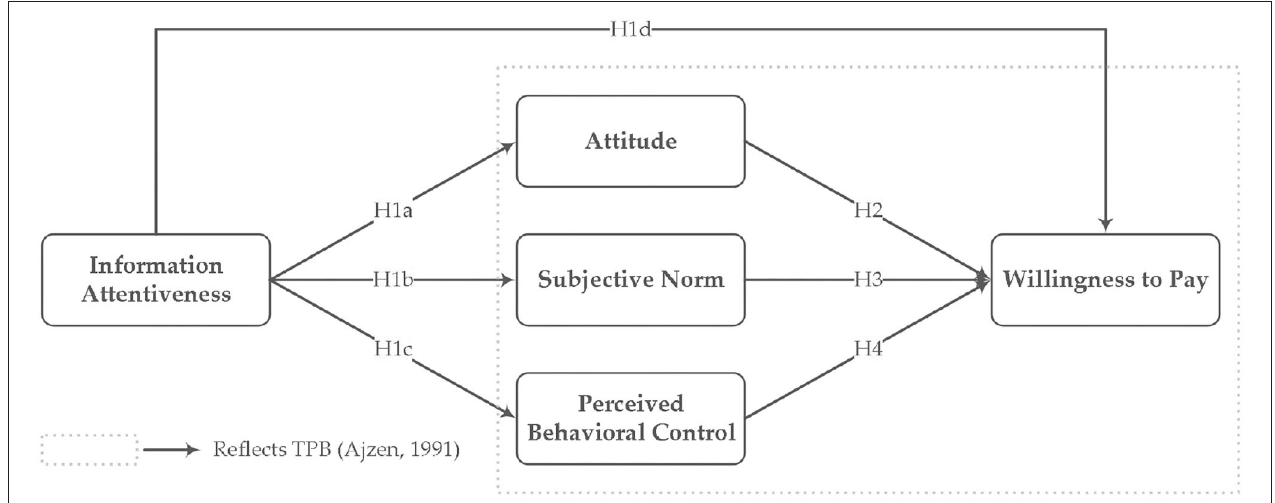
FIGURE 1 | Conceptual model and hypotheses.